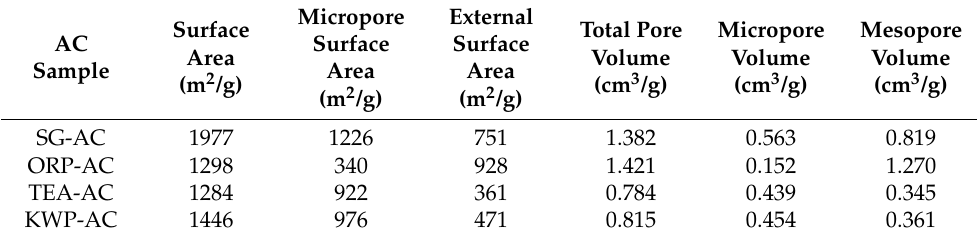
Table 2. Details of the textural parameters of the yielded AC